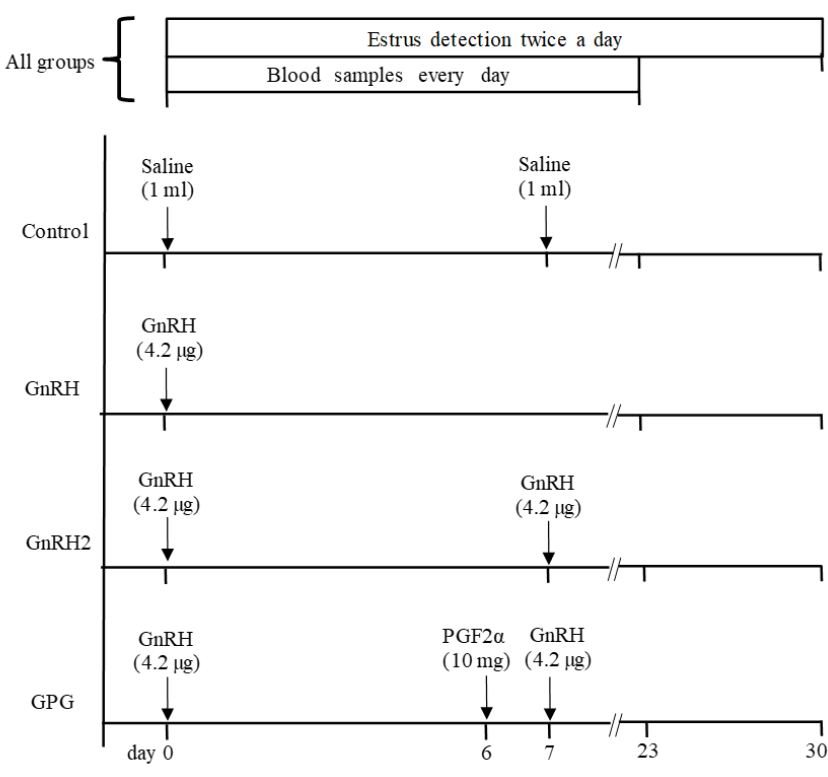
Figure 1. Schematic diagram of the schedule of activities and treatments in experiment